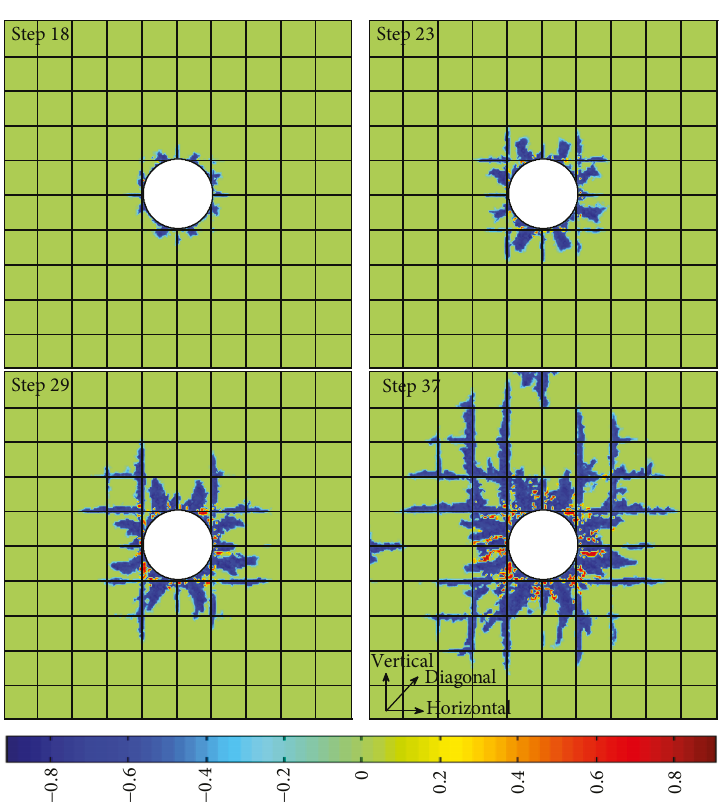
Figure 14: Distribution and evolution of the fracture in the orthogonal jointed